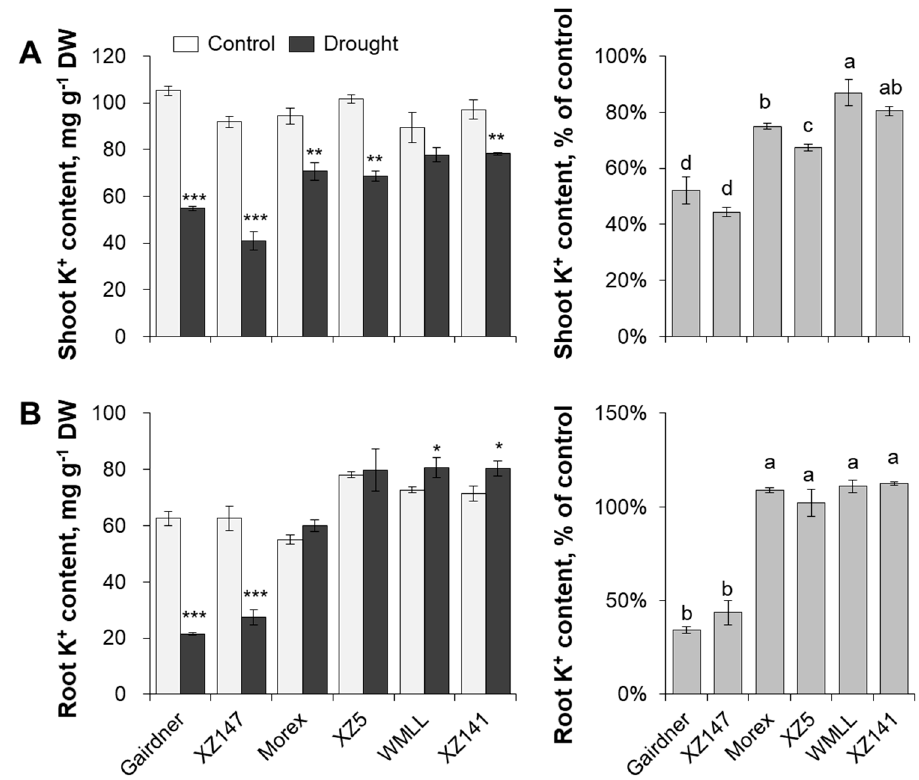
Figure 5. Effect of water-limited drought stress on tissue K + contents of barley seedlings. Twelve-day-old barley seedlings were subjected to drought stress. Plants were harvested for K + contents in shoot ( A ) and root ( B ) at 10 d after onset of treatments. Vertical bars represent means ± SE of fi ve replicates. Asterisks indicate the significant di ff erence between treatments at * p < 0.01, ** p < 0.01 and *** p < 0.001. Di ff erent lowercase letters indicate the significant di ff erence between genotypes at p < 0.01.